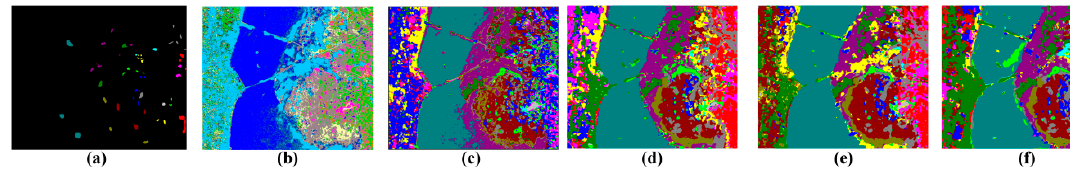
Figure 11. Classification results obtained from the KSC data set using different methods. ( a ) Ground-